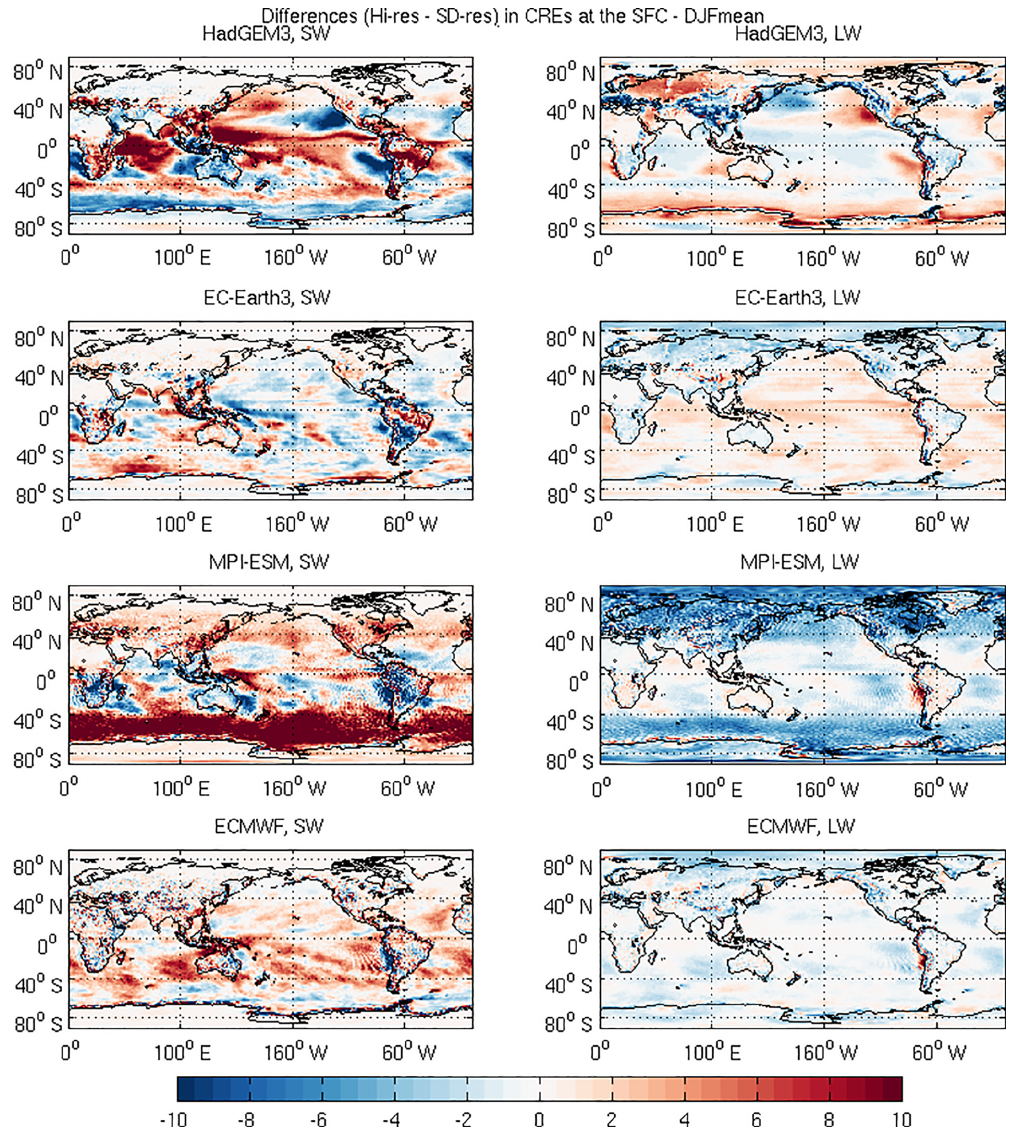
Figure A1. Differences in the CREs at the SFC during DJF (Wm − 2 ) between the Hi-res and Std-res of the respective models in the SW (left) and LW